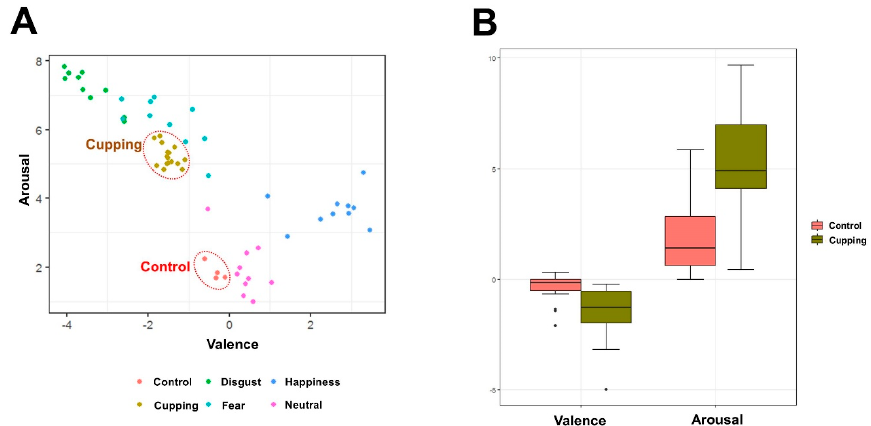
Figure 2. Valence and arousal ratings of visual stimuli. A : Each image was plotted in two-dimensional affective space, as defined by its mean valence and arousal ratings. Emotional arousal increases as hedonic valence ratings become increasingly more pleasant or unpleasant. B : Comparison of the valence and arousal ratings in response to the cupping therapy images and the control images. Cupping therapy images were rated as more unpleasant and more arousing than control images.